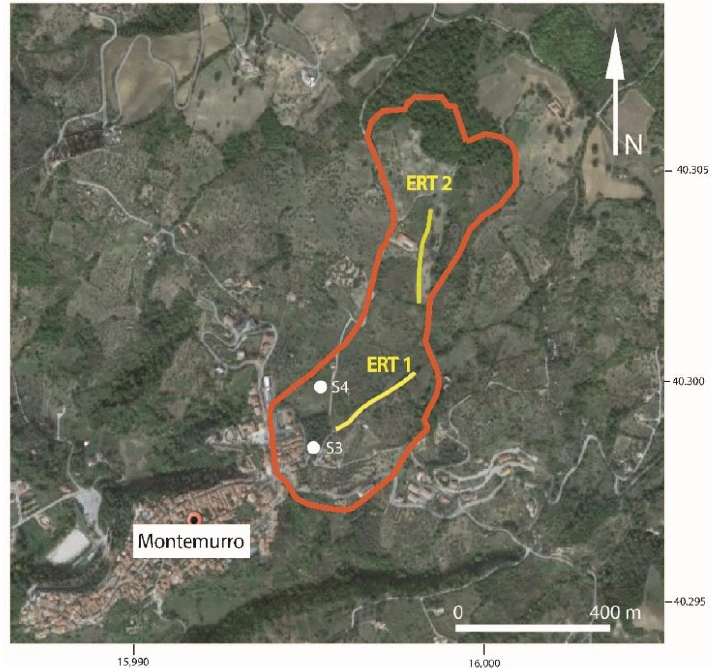
Figure 9. Traces of the two ERTs (in yellow) and the limit of the Servigliano landslide (in orange). Satellite image from Google Earth TM . The map also shows the two boreholes (S3 and S4).